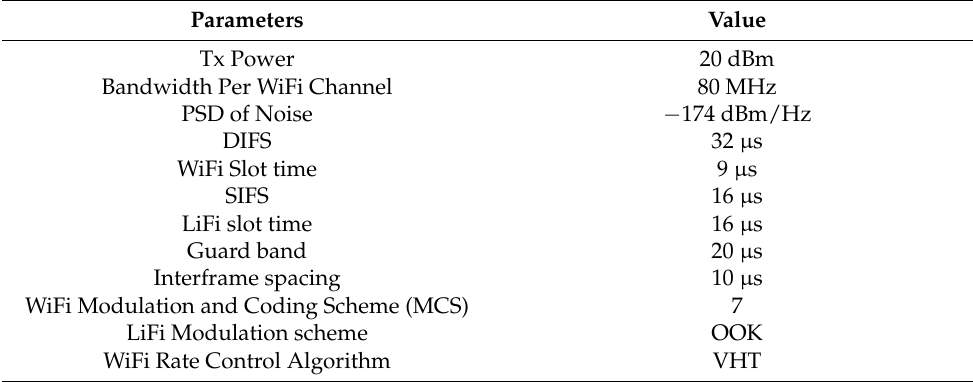
Table 2. WiFi Simulation